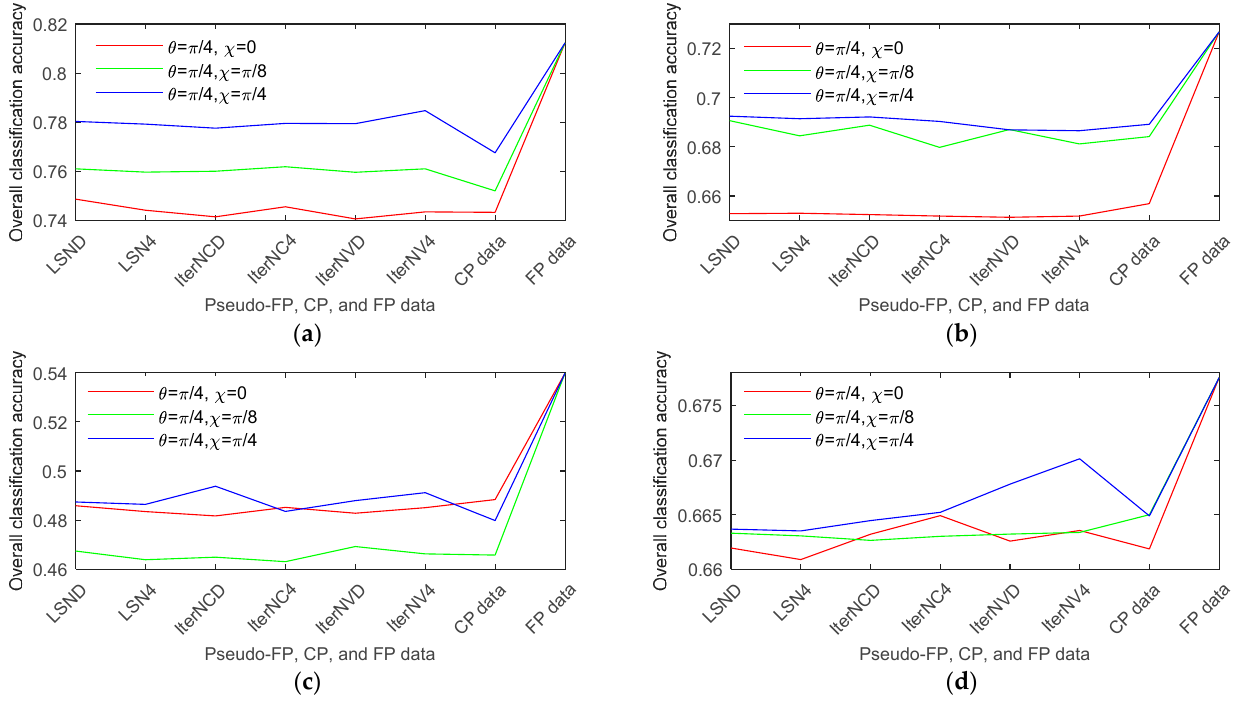
Figure 9. Overall classification rates for the agriculture field by using the pseudo quad-pol data reconstructed by the LS-based and iterative methods, the original 2 × 2 CP covariance matrix data, and the FP data. Data acquired on ( a ) 20140528, ( b ) 20140621, ( c ) 20140715, and ( d ) 20140808.